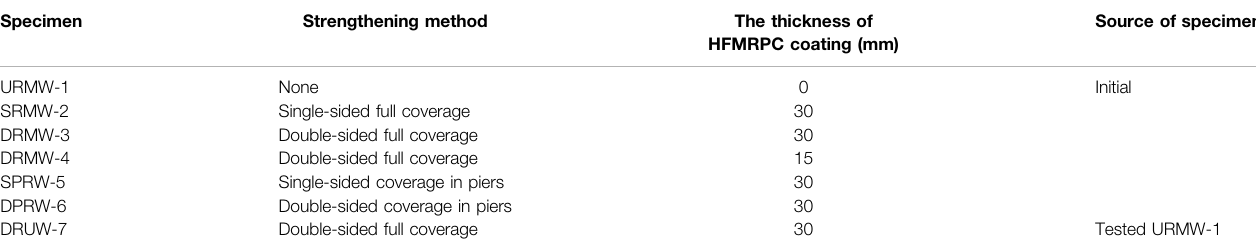
TABLE 2 | Strengthening methods for the tested walls.